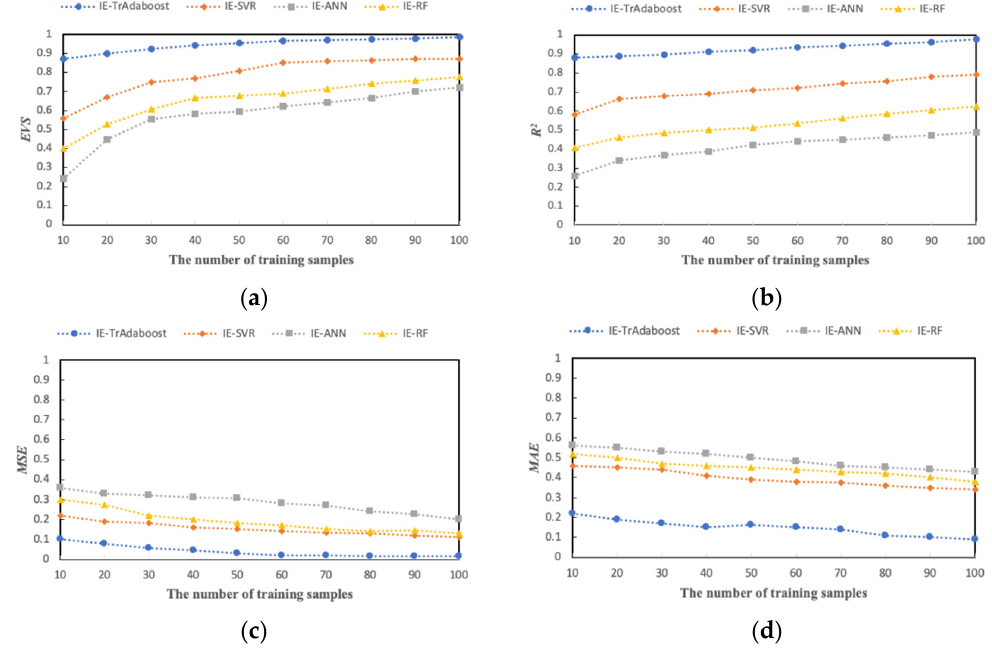
Figure 9. The performances of prediction model with KAFPs selection. (( a ) EVS; ( b ) R 2 ; ( c ) MSE;